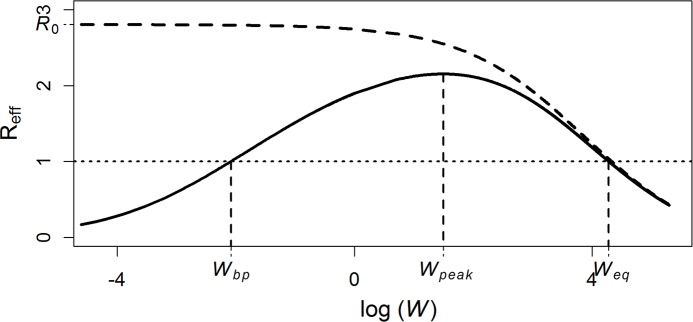
The Reff profile.An Reff profile with equilibria noted at both low (unstable; Wbp) and high (stable; Weq) parasite burdens. Between these equilibria lies a point of parasite burden (Wpeak) where intense transmission is expected (transmission being proportional to the value of Reff) due to minimized influence of restrictive negative density dependence and facilitation of transmission through amplified positive density dependence. The critical influence of positive density dependence on expected values of Reff at low worm burdens (solid line) and its deviation from expected values in the absence of positive density dependence (dashed line), where Reff → R0, is also shown.